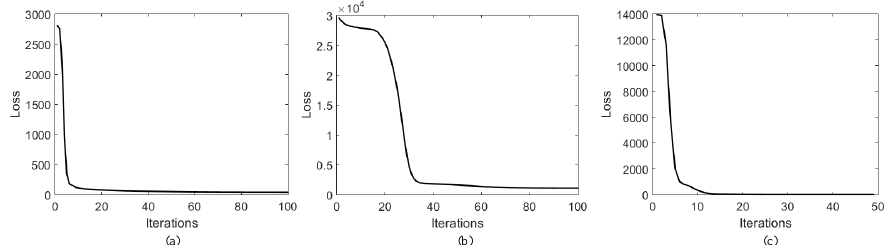
Figure 12. The evolution of the objective function of the proposed model with respect to the number of iterations for three datasets: ( a ) Indian Pines , ( b ) Pavia University and ( c ) Salinas